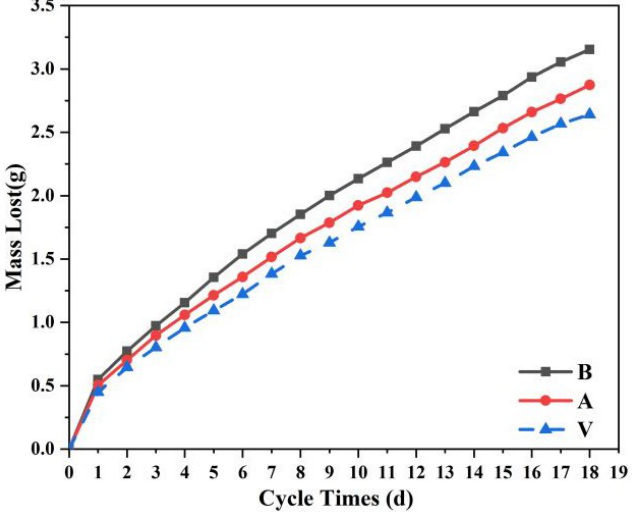
Figure 15. Water vapor permeability curve. B is a blank stone sample, A is an aragonite-treated sample, and V is a vaterite-treated sample.